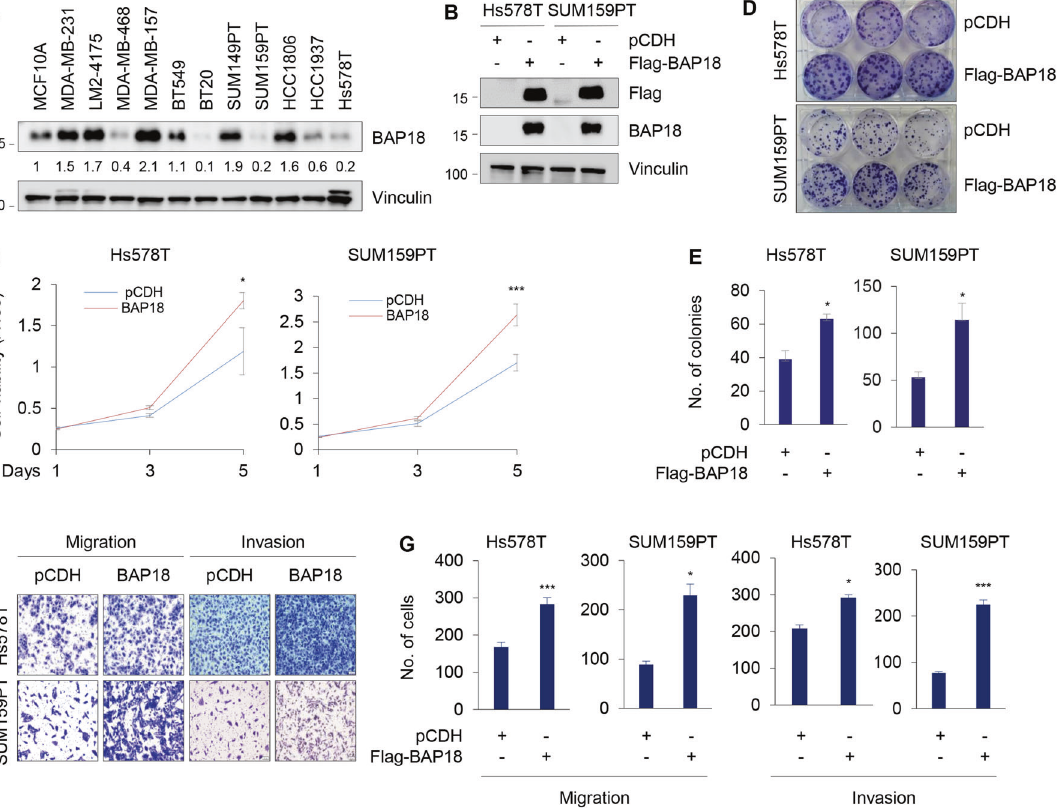
Fig. 2 Ectopic expression of BAP18 promotes TNBC cell proliferation, migration, and invasion in vitro. A Cellular lysates from 11 TNBC cell lines and human mammary epithelial cell line MCF10A were subjected to immunoblotting analysis with the indicated antibodies. B Ectopic expression of BAP18 in SUM159PT and Hs578T cells by lentiviral infections. The expression status of BAP18 in these cell lines was validated by immunoblotting. C – E SUM159PT and Hs578T cells stably expressing pCDH and Flag-BAP18 were subjected to CCK-8 assays ( C ) and